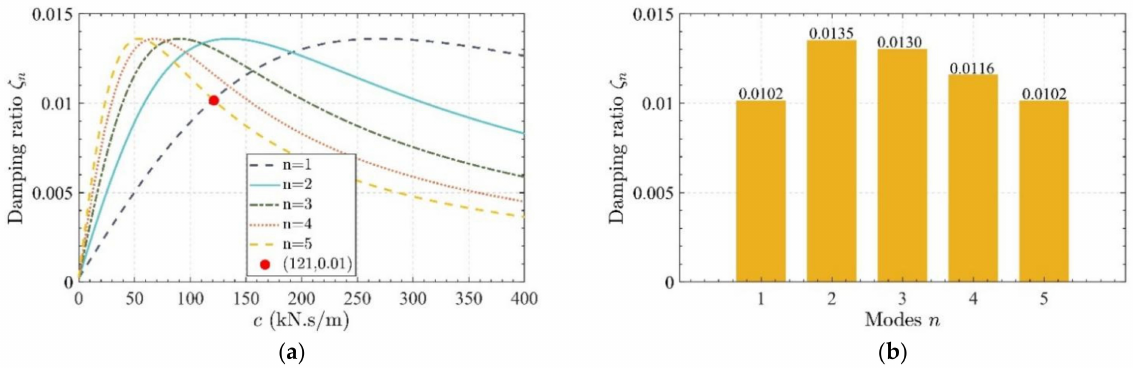
Figure 9. Optimal design of damper considering internal rubber damper: ( a ) design of viscous damper; ( b ) multimode damping